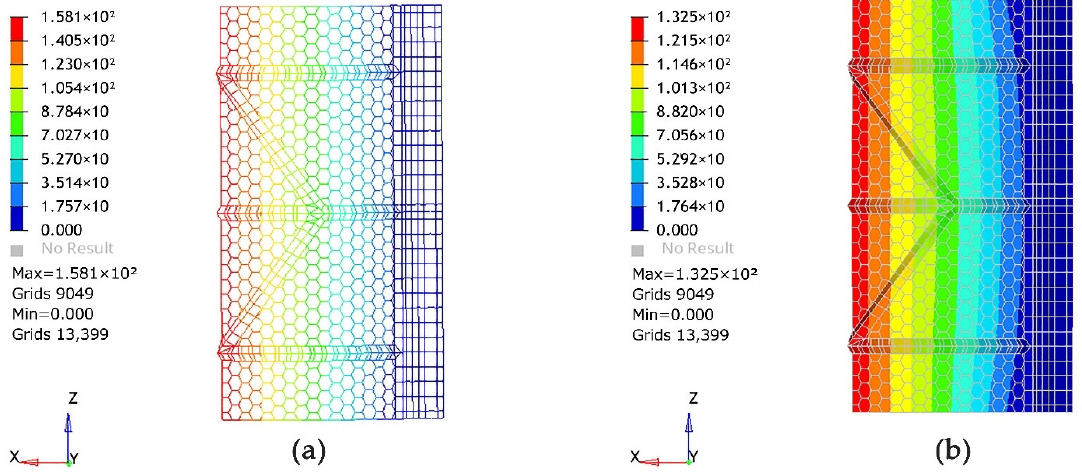
Figure 9. Numerical diagram of the stiffness of model I under permanent load. ( a ) Deflection diagram under self-weight of model I skeleton structure. ( b ) Deflection diagram of model I skeleton with membrane fabric under self-weight.